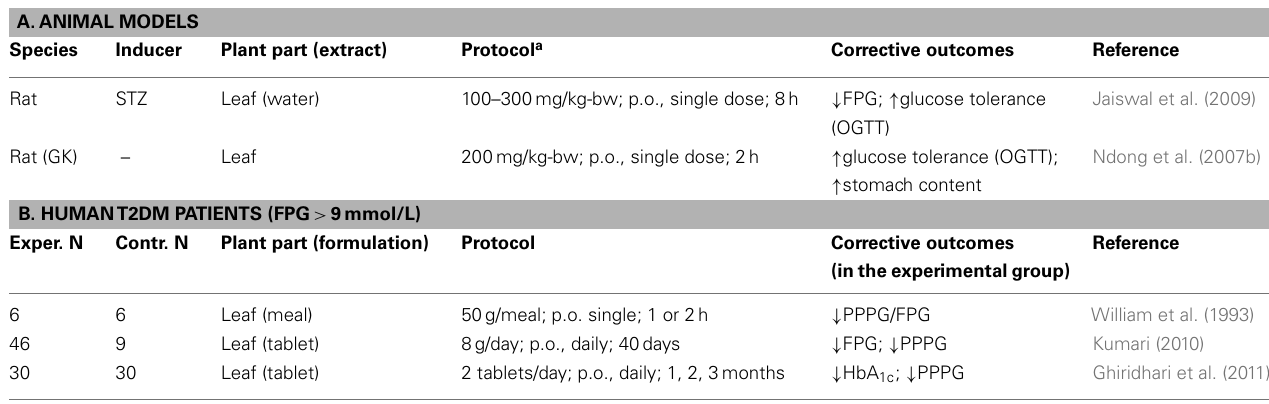
Table 1 | Moringa oleifera experimental therapy for chronic